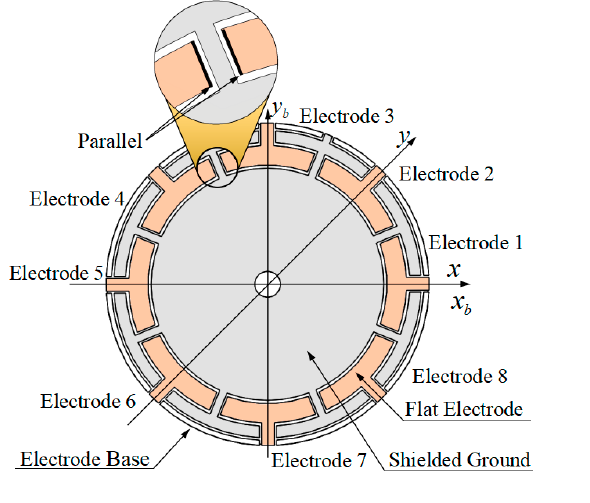
Figure 7. Assemble errors and parameters caused by assemble procedure: ( a ) Inclination angle of hemispherical resonator symmetric axis and average gap between end face of resonator lip and electrode base; and, ( b ) Direction angle of resonator symmetric axis.